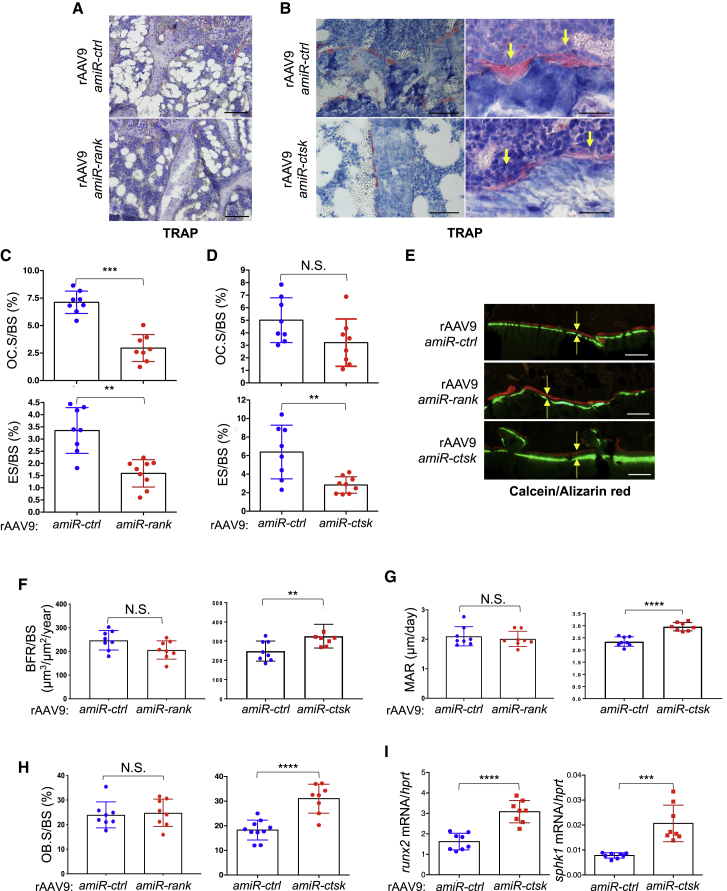
rAAV9-Mediated Gene Silencing in OCs Inhibits Bone Resorption in MiceA single dose of 8 × 1011 GC of rAAV9 carrying amiR-ctrl, amiR-rank, or amiR-ctsk was i.v. injected into 2-month-old female mice. Two months later, histomorphometry was performed in the metaphysis of treated femurs to assess in vivo OC and osteoblast activities. (A–H) Quantification of OC.S/BS, ES/BS (C and D), BFR/BS, MAR (F and G), OB.S/BS (H), and representative TRAP-stained femurs (A and B) and calcein/alizarin red-labeled femurs (E) are displayed (n = 8/group). Arrows indicate OCs residing on the bone surface (B, right) and the distance between calcein and alizarin red labeling (E). (I) mRNA levels of runx2 or sphk1 in the tibia were assessed by RT-PCR. OC.S/BS, osteoclast surface/bone surface. ES/BS, erosion surface/bone surface; BFR/BS, bone formation rate/bone surface; MAR, mineral apposition rate; OB.S/BS, osteoblast surface/bone surface. Scale bars, A and B (left), 100 μm; B (right) and E, 50 μm. Values represent mean ± SD. ∗p < 0.05, ∗∗p < 0.01, ∗∗∗p < 0.001, ∗∗∗∗p < 0.0001 by an unpaired two-tailed Student’s t test and one-way ANOVA test. N.S., not significant.